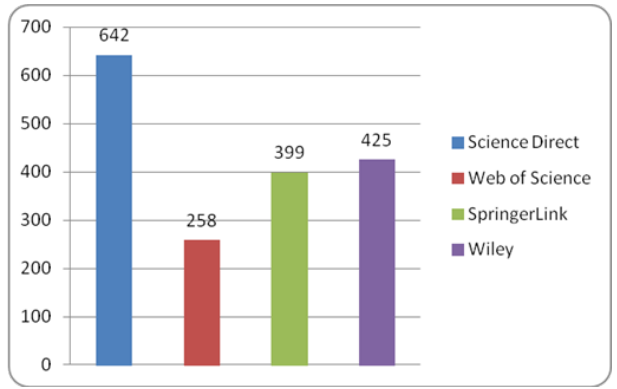
Figure 1. . Distribution of papers in